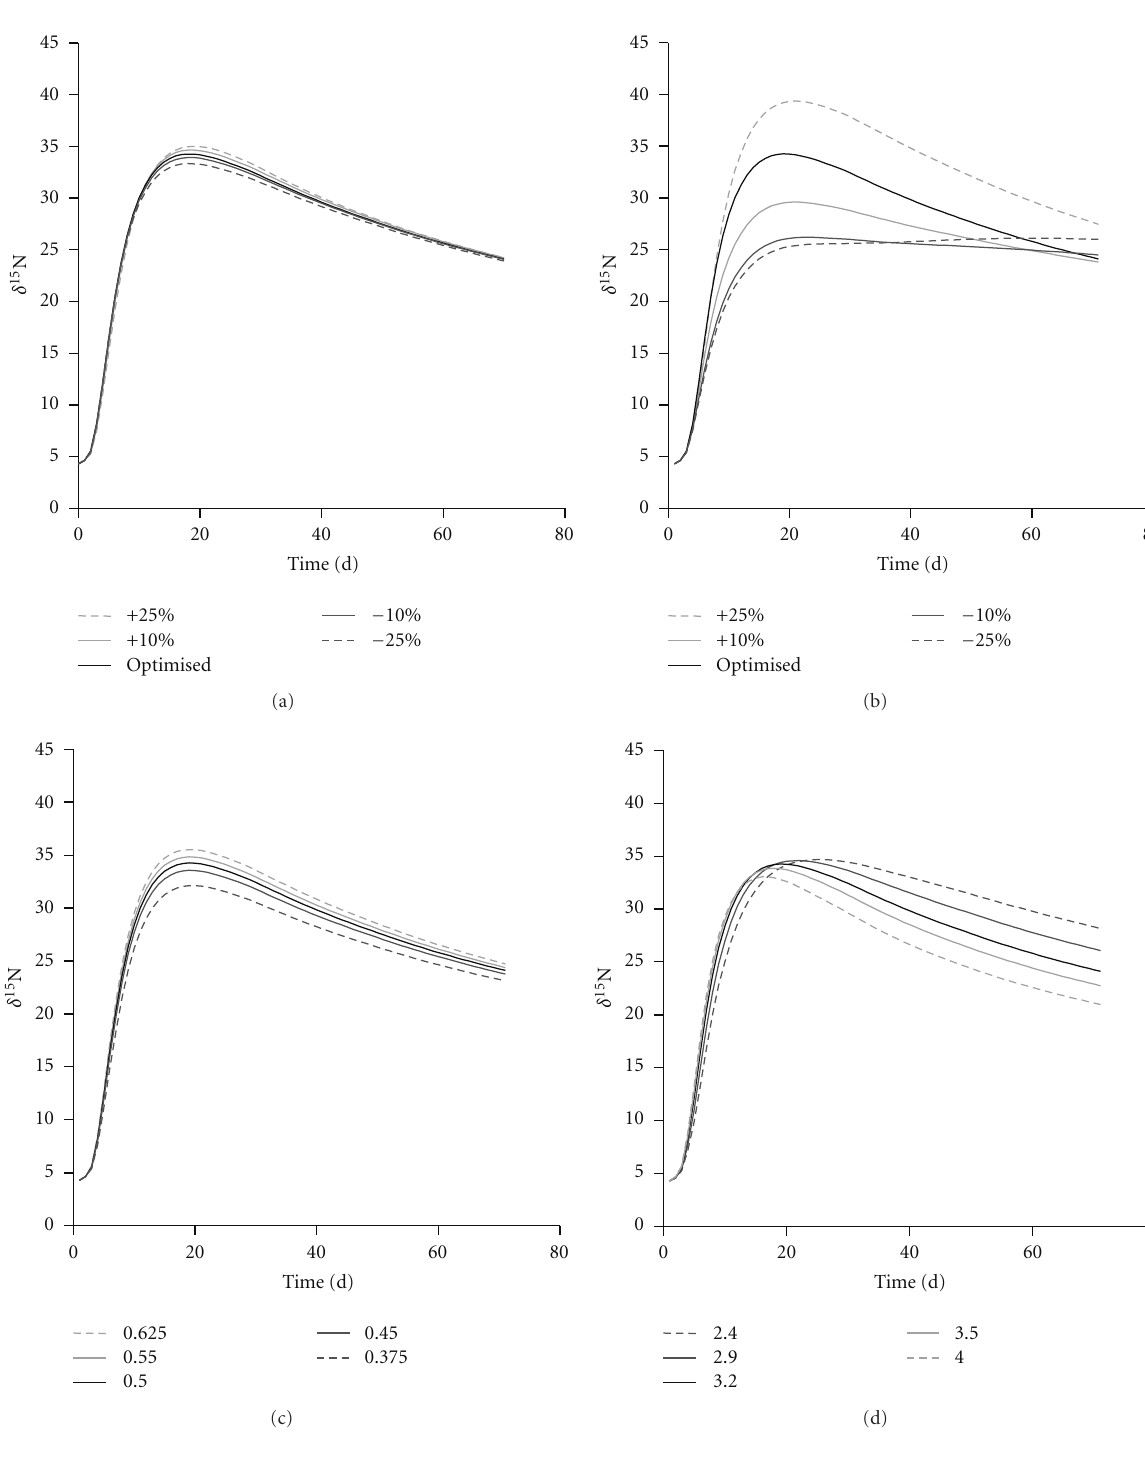
Figure 6: Sensitivity analysis for the residue application experiment (RA). Change in δ 15 N of the N recipient plant with the change of (a) residue decomposition rate constant, k , (b) C: N of microbial biomass involved in residue decomposition, R B , (c) N source factor for the N recipient plant, Sf, and (d) N uptake rate by the N recipient plant. The actual values in time were varied between − 25% and +25% of the values with which the model was optimised. Exact values are given for those parameters which have a fixed value in the model (c,